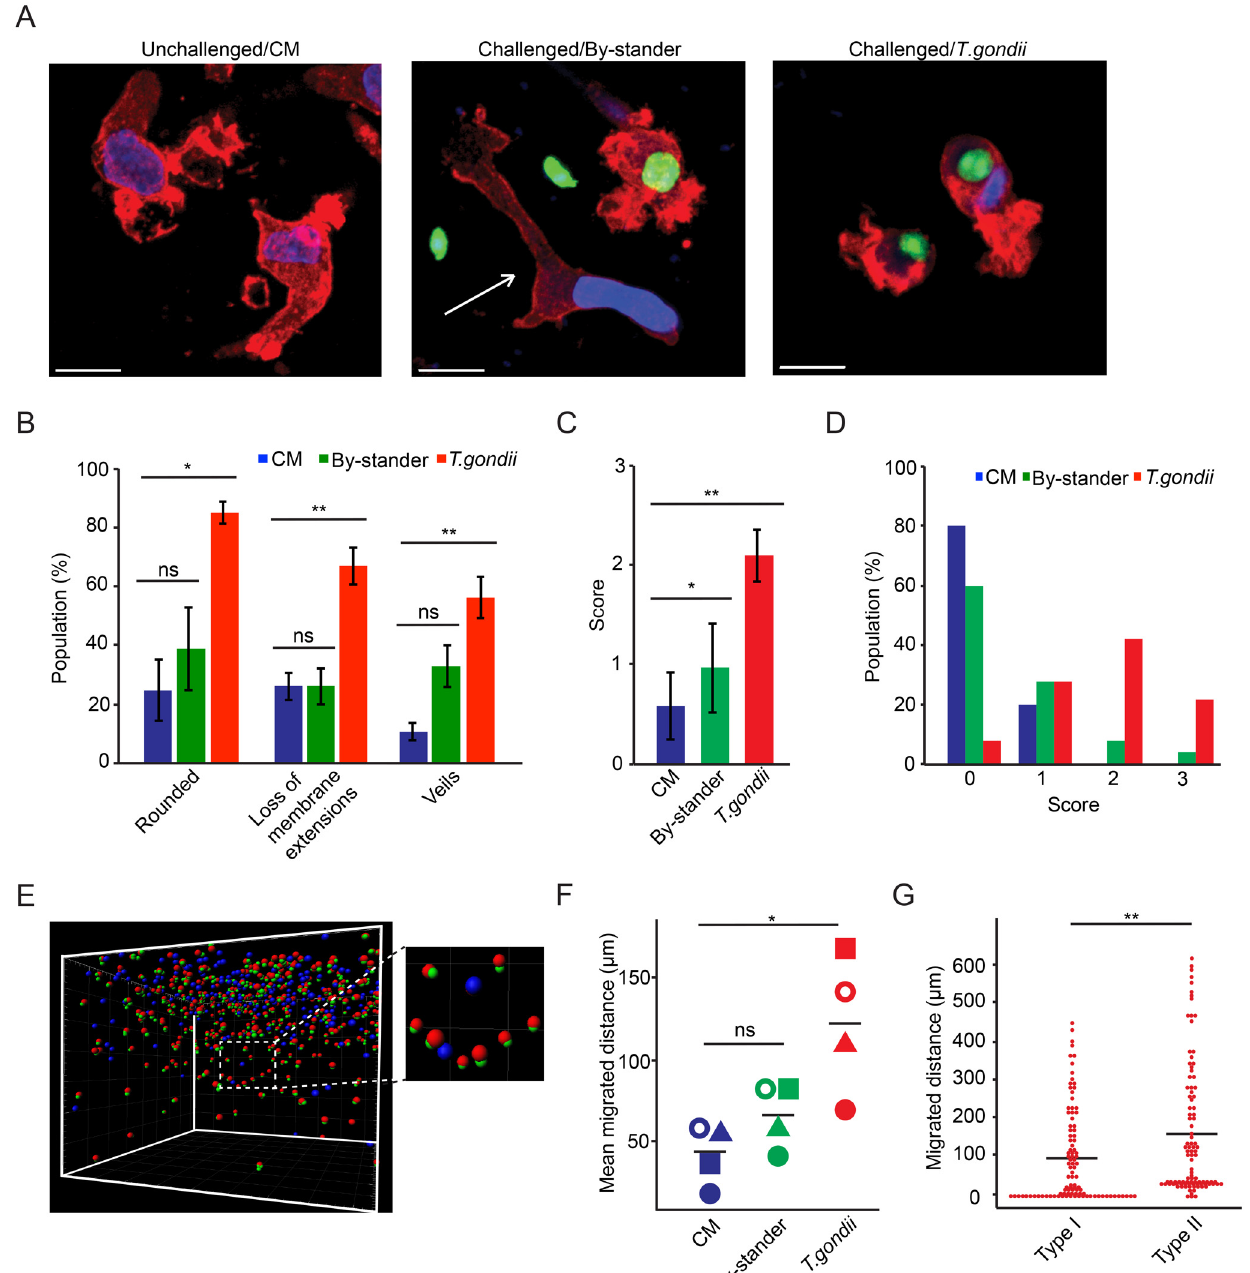
Fig 3. Morphological characteristics and migration of Toxoplasma -infected DCs and non-infected DCs in the 3D matrix. ( A ) Representative micrographs in maximum intensity projection of unchallenged DCs in complete medium (CM, left), Challenged/By-stander DCs (middle) and Challenged/ T . gondii DCs (right; PTG-GFP type II , MOI 3, green) in a 3D collagen matrix, stained with DAPI (blue), and Alexa Fluor 594-Phalloidin (red) to detect F-actin as indicated under Materials and Methods. In the middle micrograph, arrow indicates non-infected DC surrounded by an infected DC (green + red) and two extracellular T . gondii tachyzoites (green). Scale bars = 10 μ m. ( B ) Graph shows, for each condition, the percentage of cells (mean ± SEM) that exhibit rounded phenotype, absence of membrane extensions and veils, respectively, related to the total cell population. The morphological criteria are specified under Materials and Methods. For each condition, a total of 50 cells/donor were analyzed from 3 different donors. ( * : P < 0.05, ** : P < 0.01, ns: P > 0.5, Paired t -test, Holm´s correction). ( C ) Compiled mean scores ( ± SD) based on morphological criteria as in (B). For each condition, a total of 50 cells/donor were analyzed from 3 different donors ( * : P < 0.05, ** : P < 0.01, Paired t -test, Holm´s correction). ( D ) Distribution of the total scores (% of total cell population) based on morphological criteria specified under Materials and Methods. For each condition, a total of 50 cells/donor from 3 donors were assessed. Significant differences were observed between tachyzoite-infected DCs and non-infected DCs (P < 0.0001; Fisher´s exact test) or by-stander DCs